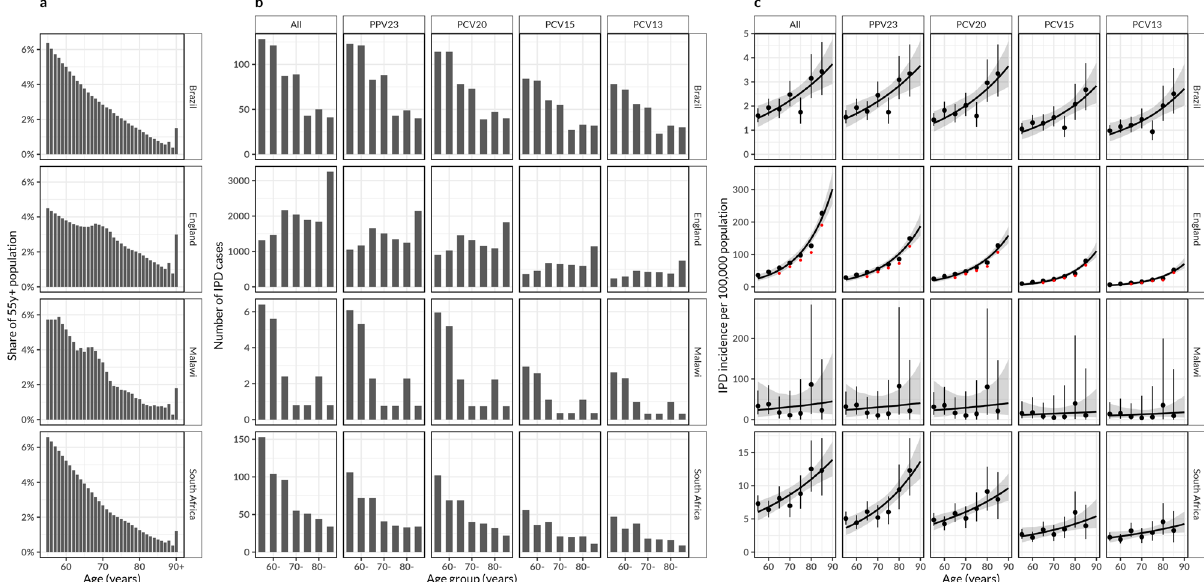
Fig. 1 | Population demographics and invasive pneumococcal disease (IPD) burden. a Among individuals who are aged ≥ 55years, the proportion/share in annual age groups in Brazil, England, Malawi and South Africa as estimated from their national censuses, based on fi ve years rolling average smoothed population countstocontrolfordemographicstochasticity. b NumberofIPDcasesin fi veyear age bands in older adults strati fi ed by serotype in Brazil (2015 – 2017), England